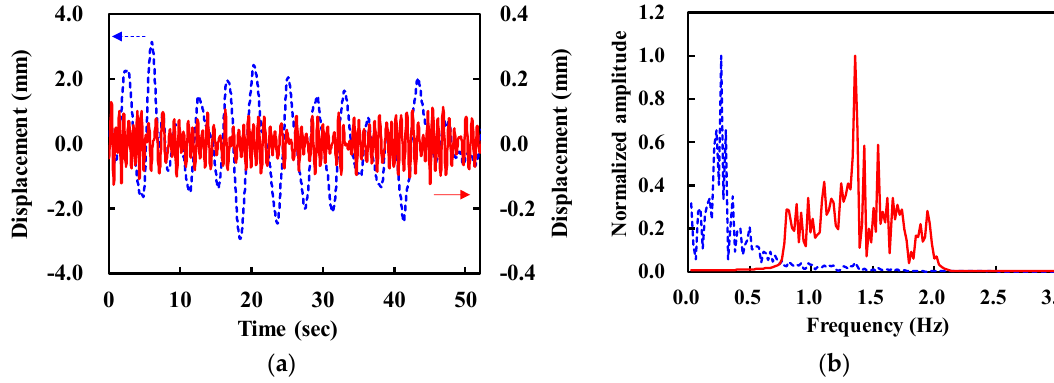
Figure 6. Extracted respiration ( x r , e [ n ] , dashed) and heartbeat ( x h , e [ n ] , solid) signal. ( a ) Time domain waveforms. ( b ) Normalized amplitude in frequency domain.